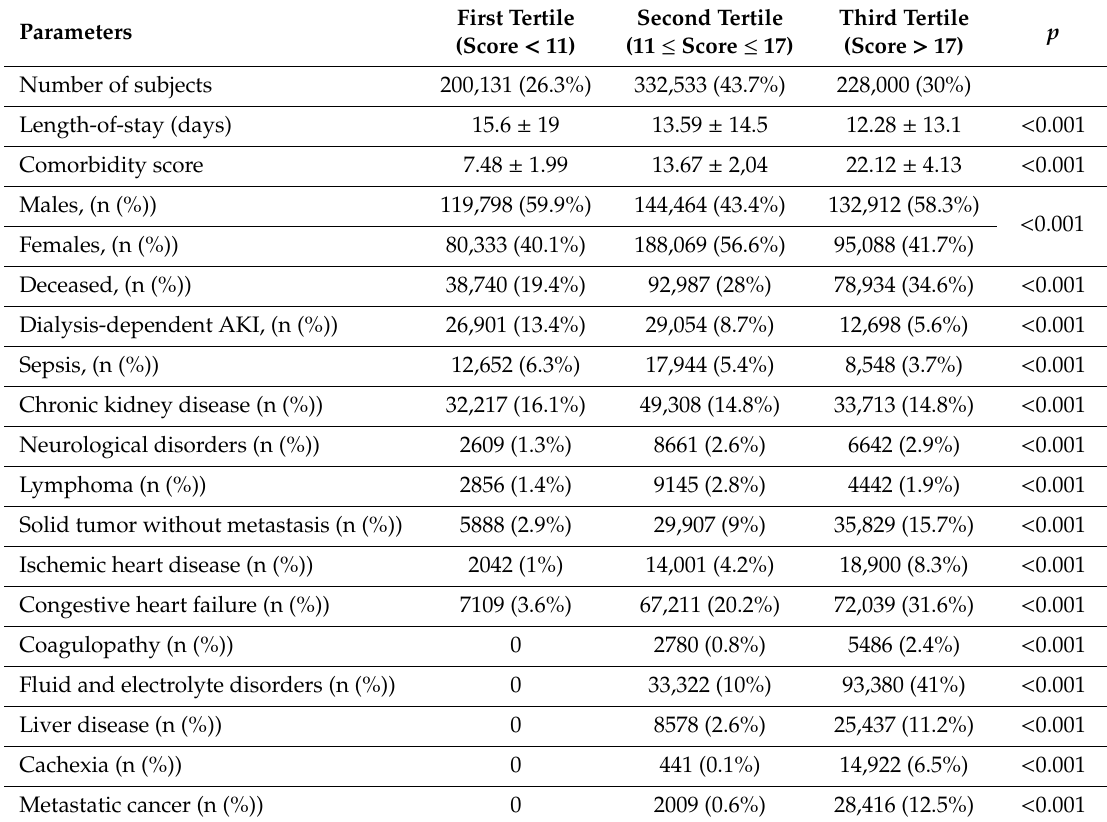
Table 4. Comparison of subjects divided into tertiles.